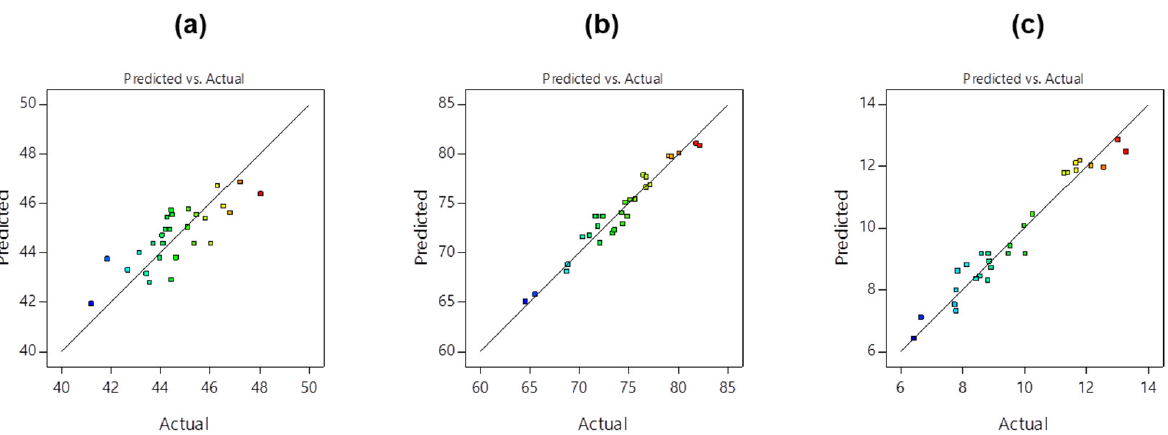
Figure 1. Comparison of experimental obtained responses and predicted values: ( a ) protein content; ( b ) fraction yield; ( c ) grinding energy consumption.